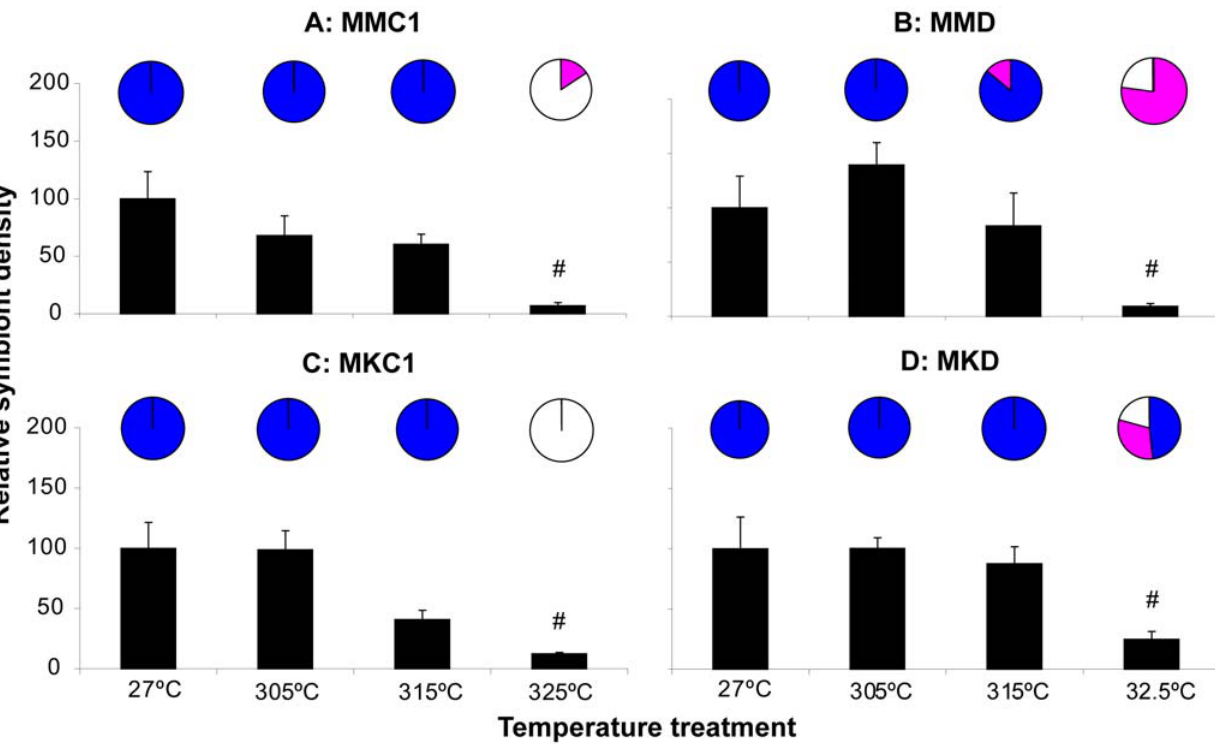
Figure 3. Heat-stress experiment 1: relative algal symbiont densities and coral condition. End effect of four different temperature regimes on the relative algal symbiont densities (bars) and coral condition (pies) of four groups of juvenile coral outplanted to Magnetic Island. See materials and methods for nomenclature. Blue=healthy, purple=pale, white=bleached. # =significantly different from lower temperatures within a group (p , 0.05). All four experimental groups exhibited a bleaching response at the highest temperature treatment, as indicated by significant reductions in relative algal symbiont densities, and the visual assessment indicated a stronger response (more bleached colonies) for C1 corals than for D